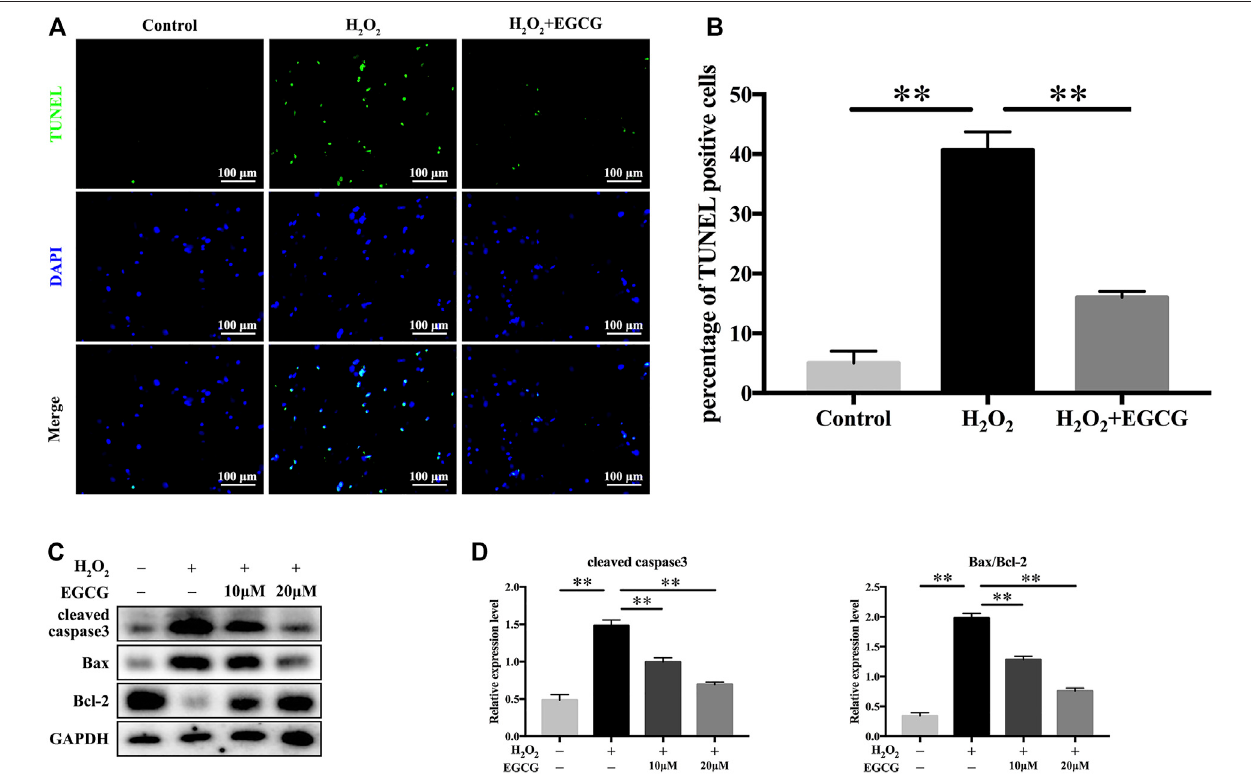
FIGURE 3 | EGCG inhibits H 2 O 2 -induced NPCs apoptosis. (A) NPC apoptosis levels in every treatment group was measured by TUNEL assay, and (B) TUNEL- positivecellswerequanti fi ed. (C) Westernblotassayforcleavedcaspase3,Bax,aswellasBcl-2expressionlevelsfollowingtreatmentwithvaryingEGCGdoses(withor without 300 μ M H 2 O 2 treatment) for 24 h. (D) Levels of various signal intensities. GAPDH was the loading control. Data are shown as mean ± SD ( n (cid:2) 3). * p < 0.05, ** p <